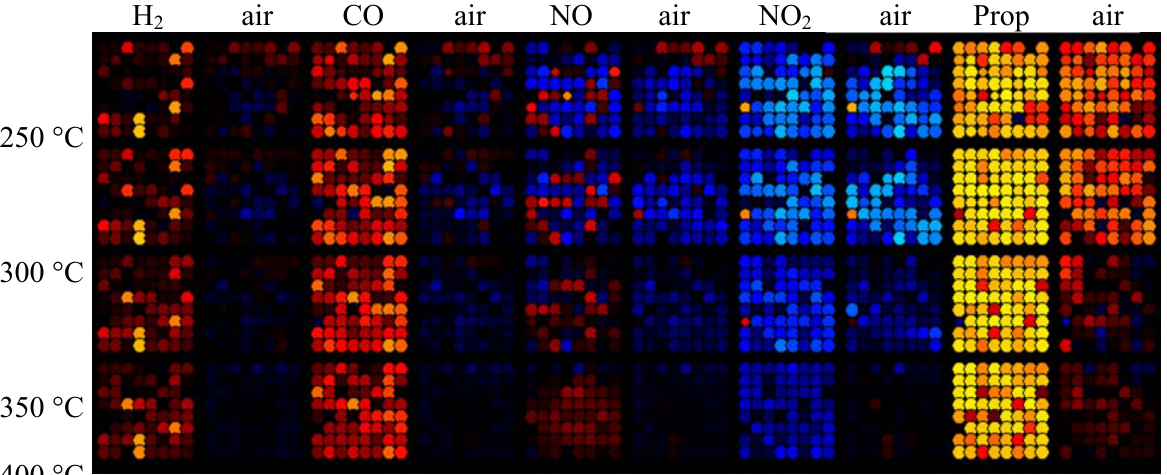
Figure 6. Trellis-plot of the relative sensitivities of the sample plate - from top to bottom with increasing temperature (250 to 400 °C) and from left to right with the sequence of the test gases (H air, CO, air, NO, air, NO , air, propene, 2